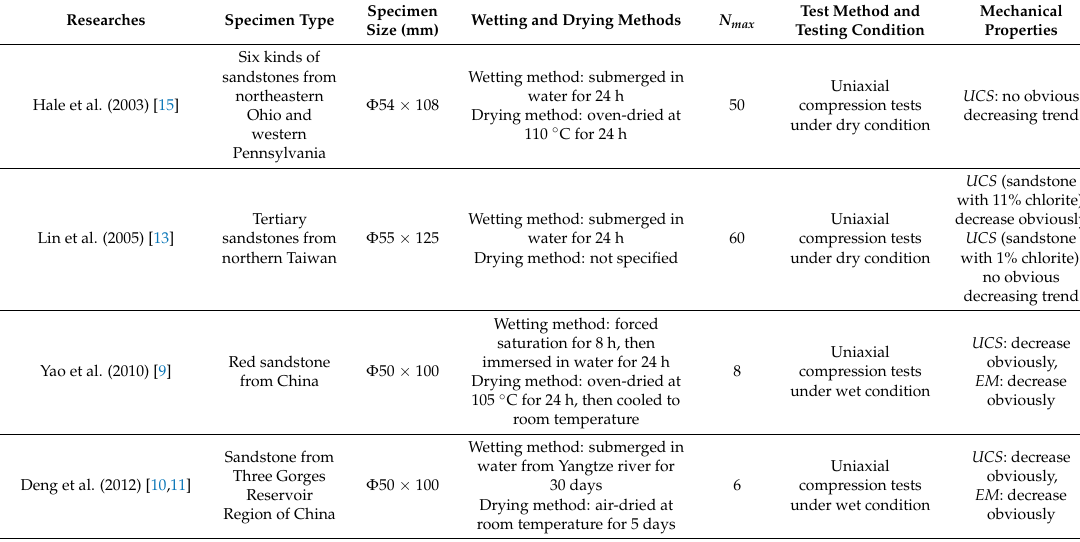
Table 1. Effects of cyclic wetting-drying on the mechanical properties of various sandstone by different